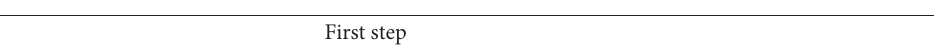
Table 2: Pulp revascularization using a triple antibiotic paste